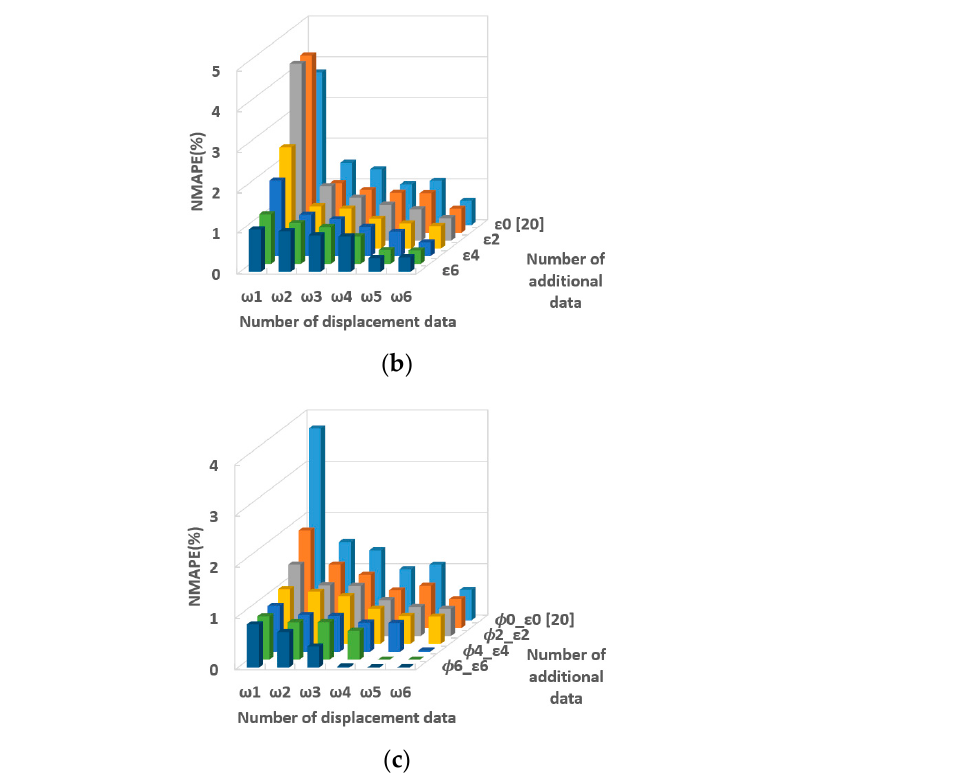
Figure 26. NMAPE according to the number and combination of sensors (RDS1): ( a ) displacement + slope, ( b ) displacement + strain, ( c ) displacement + slope + strain.